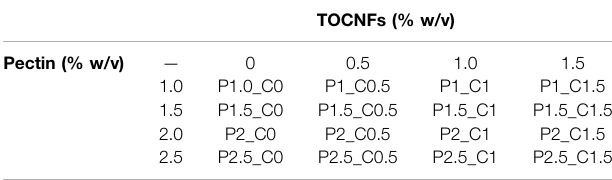
TABLE 1 | Multicomponent pectin and TEMPO-Oxidized Cellulose Nano fi bers (TOCNFs) hydrogels designed by varying the concentrations of the two componentsinthe fi nalinks.The fi rstpartofthenameoftheinkreferstothepectin